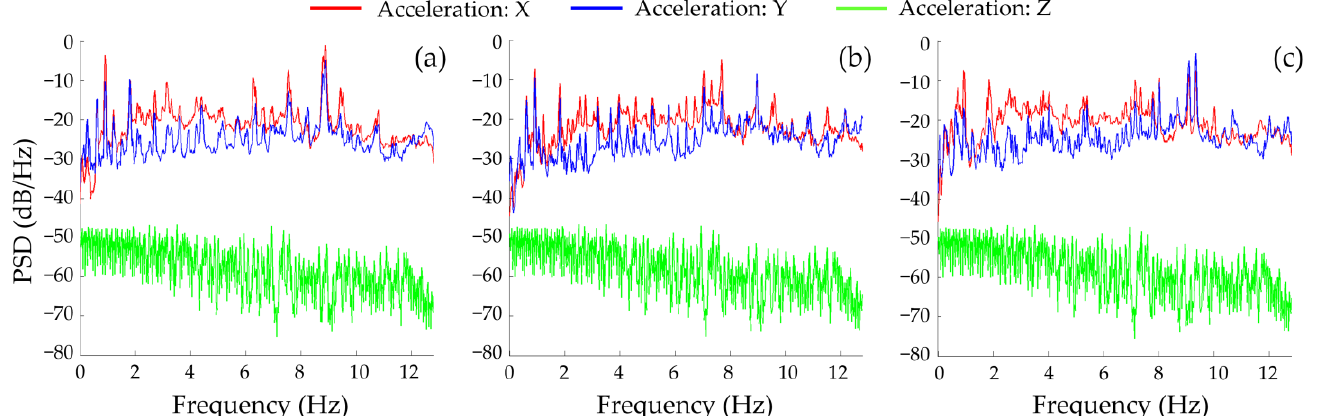
Figure 7. PSD analysis of the measured vibrational exposure on the operator seat for different driving surfaces: soil surface ( a ), unpaved road ( b ), and asphalt road ( c ) under the unloaded operating condition.